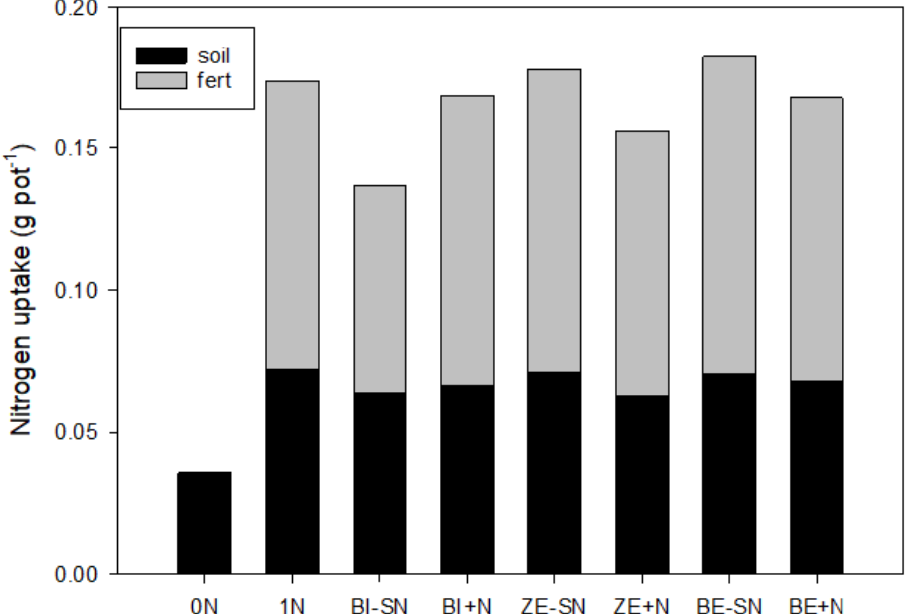
Figure 2. Plant N uptake from soil (black) and from applied fertilizer (grey) calculated from 15N signature. 0N = no fertilizer, 1N = full mineral N fertilizer, no sorbent, BI = biochar sorbent, ZE = zeolite sorbent, BE = bentonite sorbent. When sorbent and N fertilizer are both mixed into the soil separately, -SN is added. When N fertilizer is applied sorbed with the sorbent +N is added.